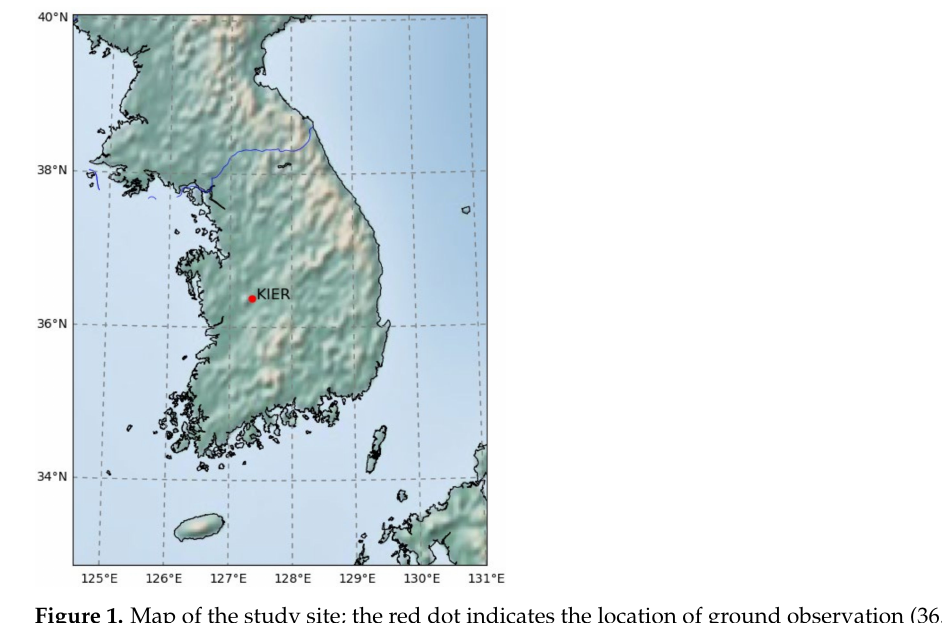
Figure 1. Map of the study site; the red dot indicates the location of ground observation (36.384 ◦ N, 127.359 ◦ E, 72